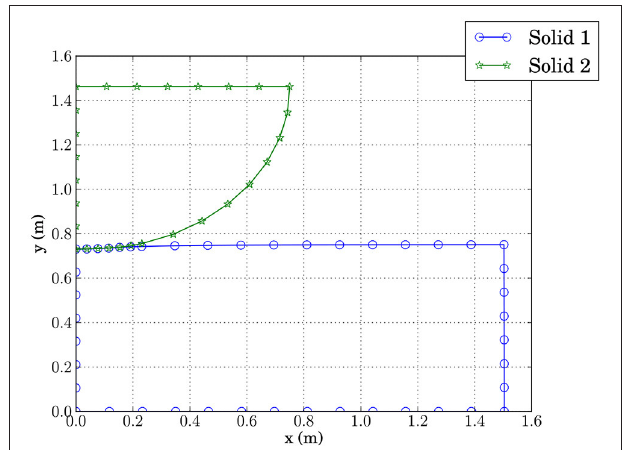
FIGURE 15 | Deformed shape predicted by EC-BEM for Mesh 1 of Table 6